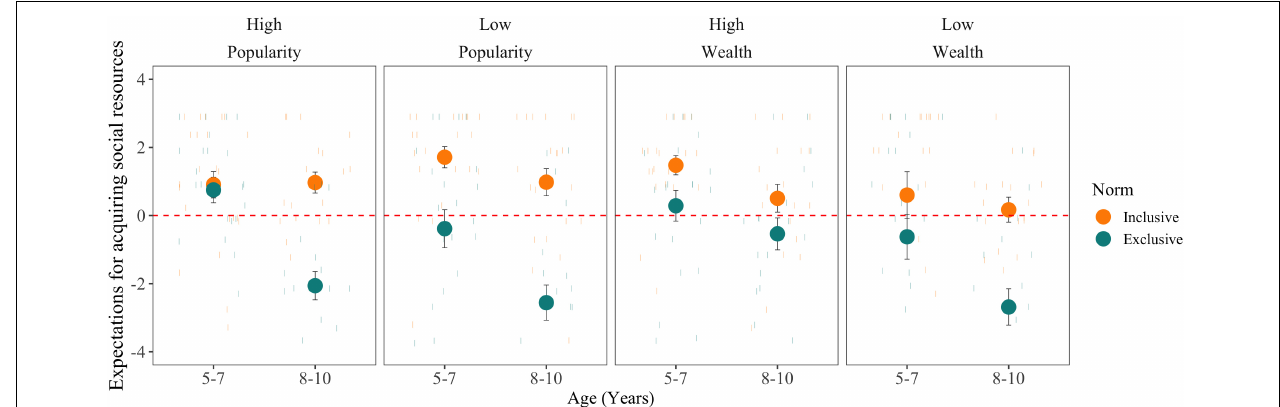
FIGURE 2 | Children’s expectations for acquiring social resources as a function of norm, status dimension, status level, and participant age (with standard error bars). Expectations for acquiring social resources are based on a composite of z -scores for children’s predictions of the group’s attitudes toward the protagonist, the protagonist’s enjoyment, and the group’s inclusion of the protagonist. A score of zero indicates the mean of each sub-measure.